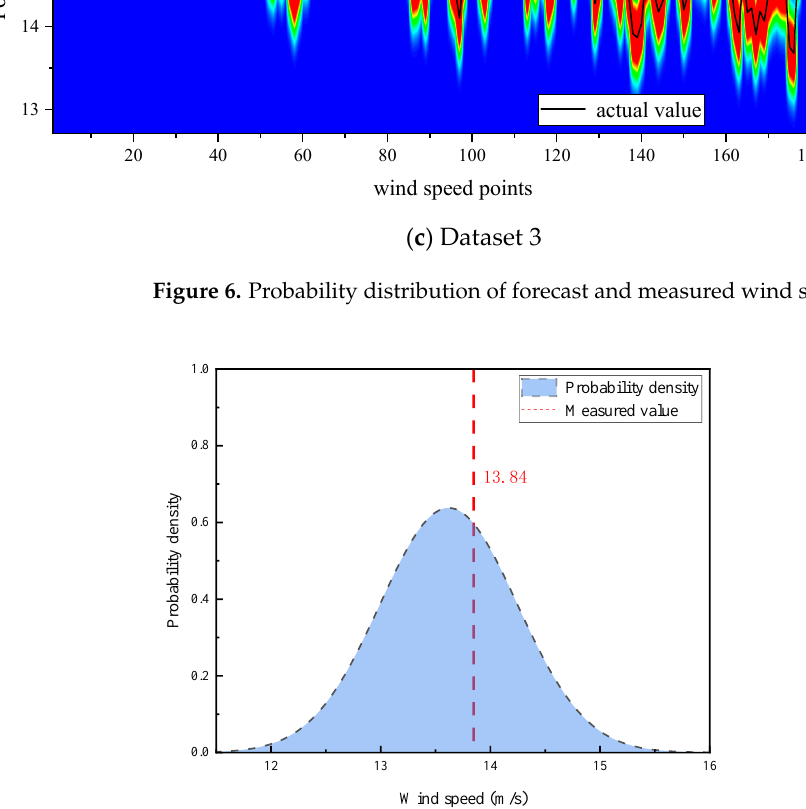
Figure 6. Probability distribution of forecast and measured wind speeds.